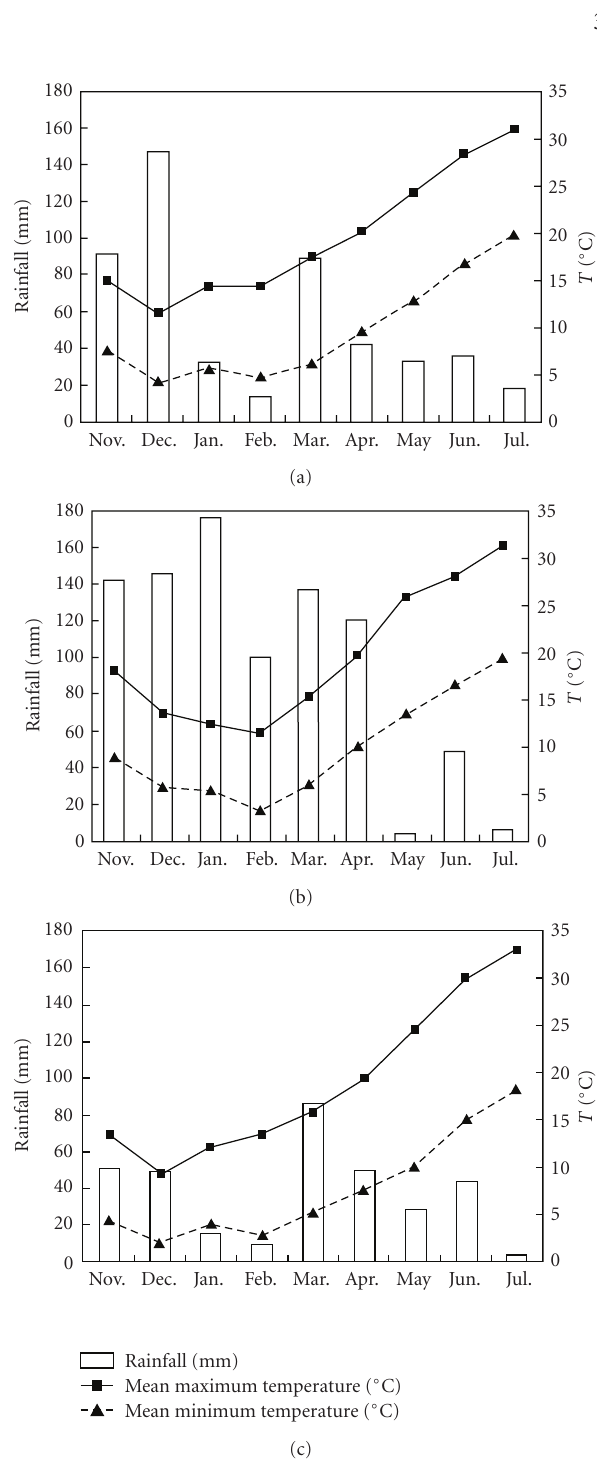
Figure 1: Trend of average minimum (dashed line) and average maximum monthly temperatures (solid line) and distribution of monthly rainfall (bars) in Valenzano 2007/08 (a), Valenzano 2008/09 (b), and Foggia 2007/08